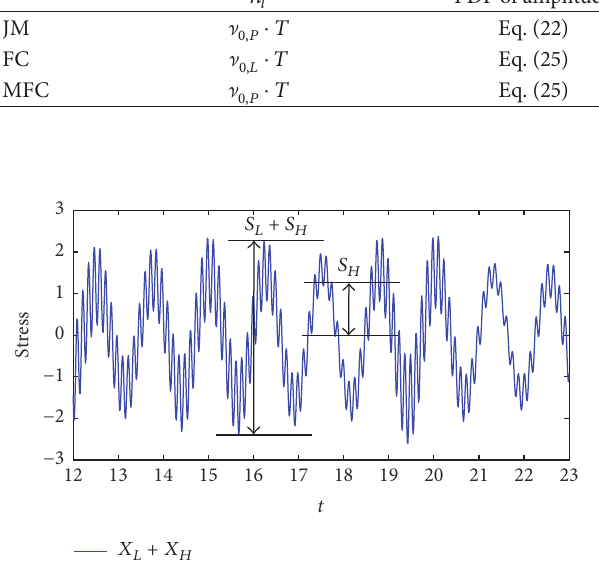
Figure 2: The large cycles and small cycles for a random stress